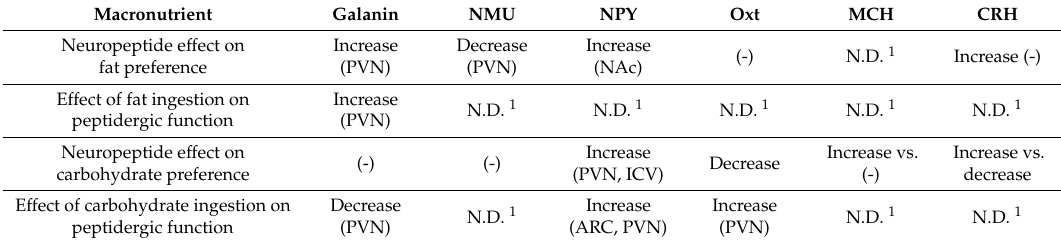
Table 3. The relationships between neuropeptides and